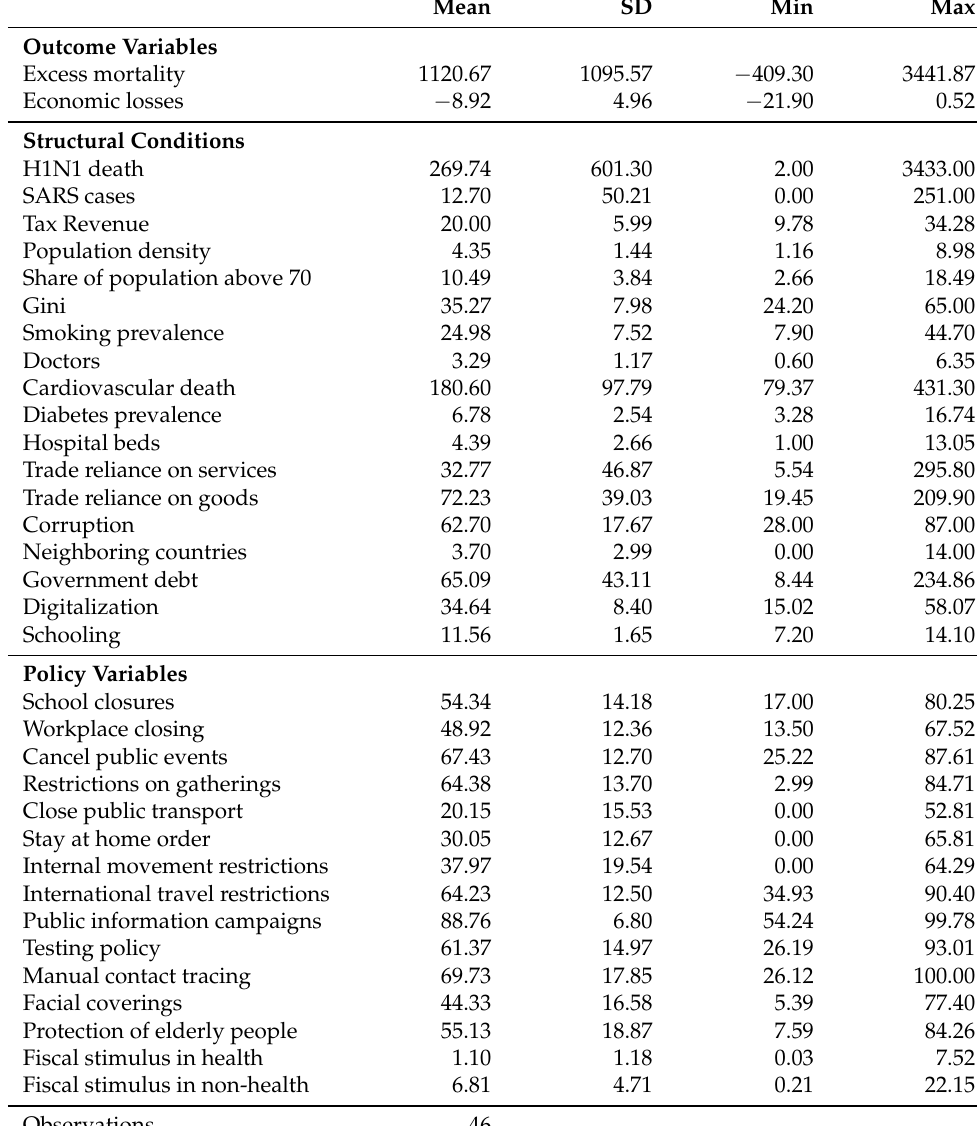
Table 1. Descriptive